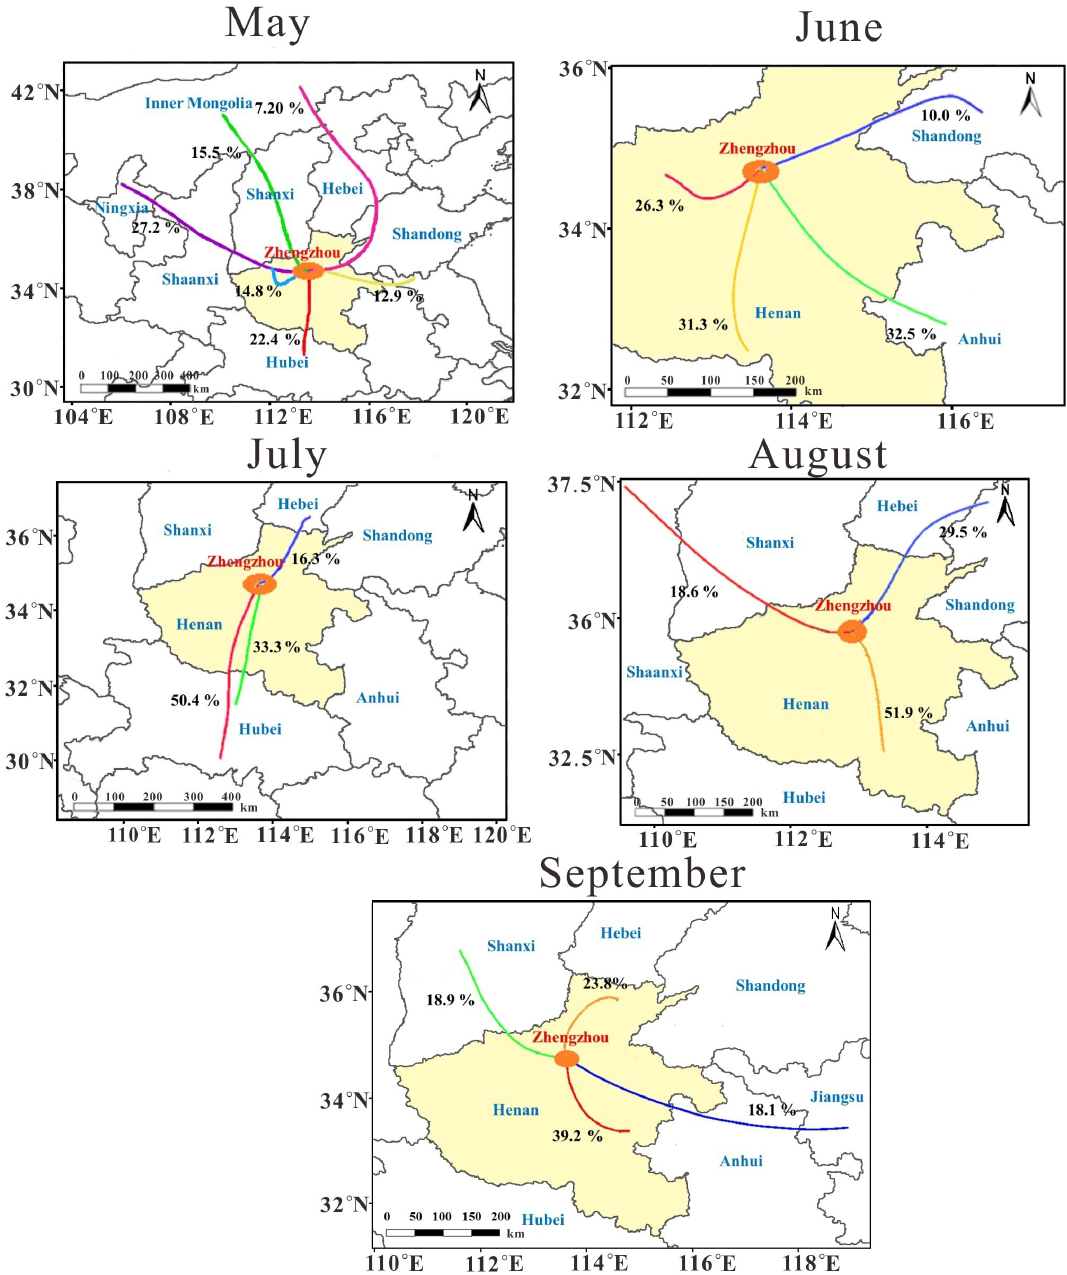
Figure 3. Cluster analysis of 48h backward trajectories for Zhengzhou in each sampling month using the HYSPLIT code, with the start height at 500m altitude and running interval set as 2h for each day; the percentage of each cluster and covered areas are presented as